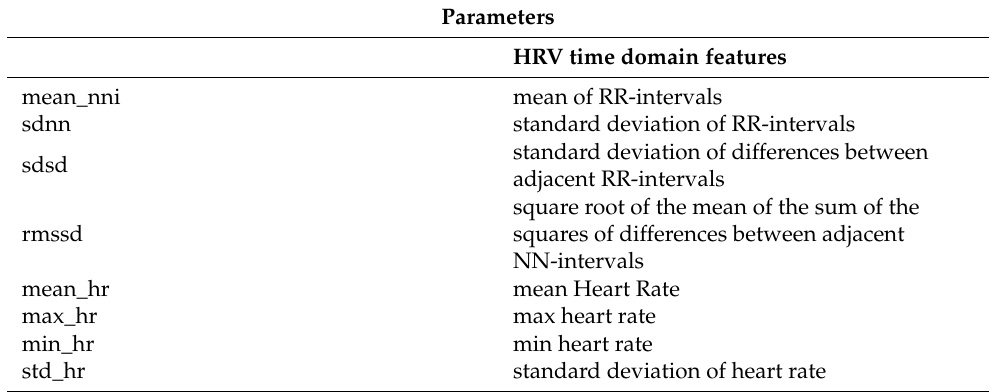
Table 4. List of extracted heart rate variability (HRV) features in traditional machine learning Parameters